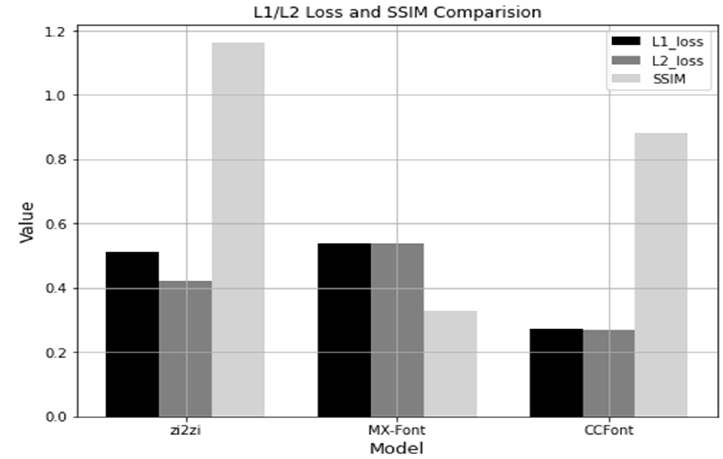
Figure 23. L1/L2 loss and SSIM comparison by models.